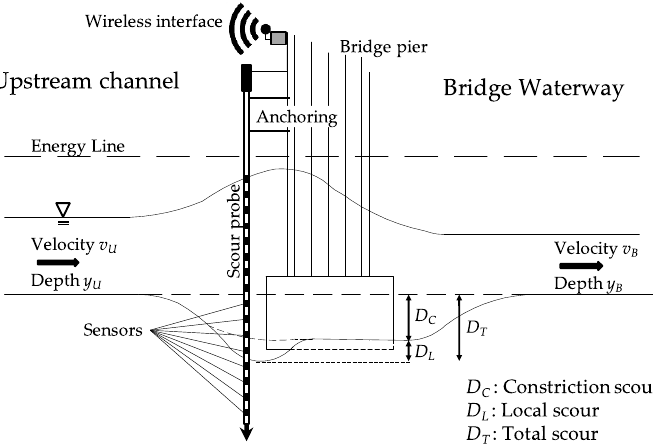
Figure 13. Outline of the pilot scour monitoring system.